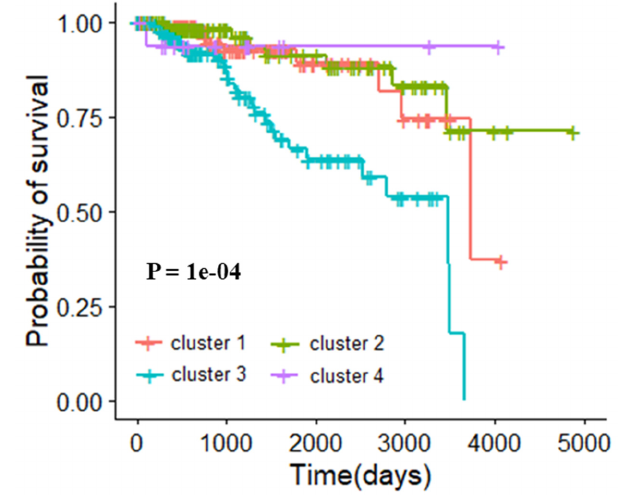
Figure 4. Survival analysis of classification by the K-means clustering algorithm in breast invasive carcinoma dataset.